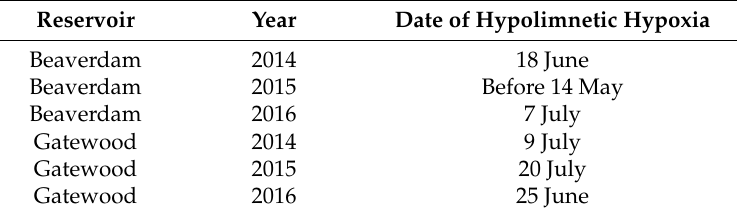
Table A1. Dates of hypolimnetic hypoxia onset (mean hypolimnetic dissolved oxygen concentrations ≤ 2 mg L − 1 ) in the two seasonally hypoxic reservoirs, Beaverdam and Gatewood. 14 May was the first sampling day for Beaverdam in